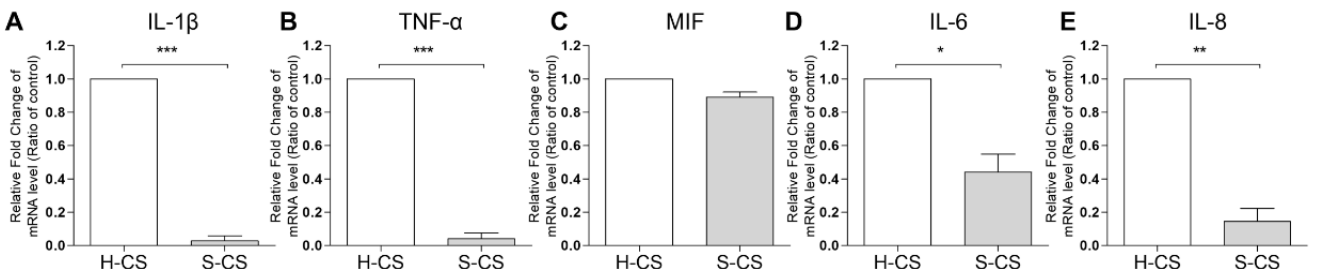
Figure 4. Comparison of the pro-inflammatory cytokine expression in heterogeneous chondrocyte sheets (H-CS) and stratified chondrocyte sheets (S-CS). To determine the proinflammatory gene expression levels, the total RNA was extracted at 3 weeks after triple layer sheets were fabricated. The mRNA levels of ( A ) IL1- β , ( B ) TNF- α , ( C ) MIF, ( D ) IL-6, and ( E ) IL-8 were measured by qRT-PCR. (*, p < 0.05, **, p < 0.01, ***, p < 0.001).